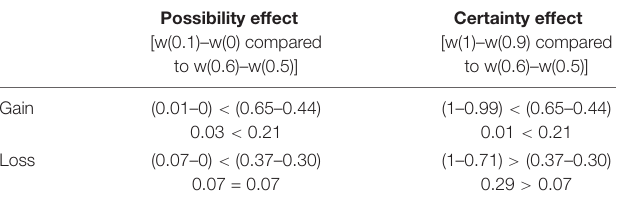
TABLE 6 | Possibility and Certainty effect in gain and loss